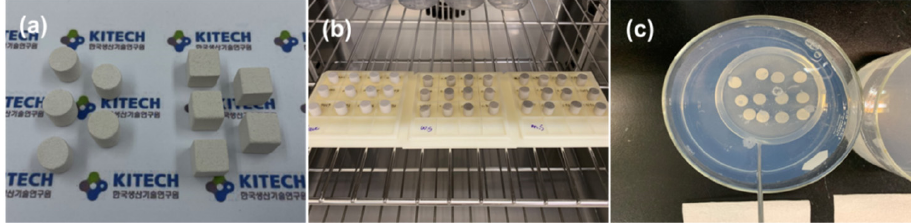
Figure 2. Powder bed 3D printing molded body ( a ) cylindrical molded body for strength confirma- tion and dice-shaped molded body for checking surface resolution and dimensional change ( b ) 12 samples for each condition for sample basic property evaluation ( c ) colloidal silica impregnation process.